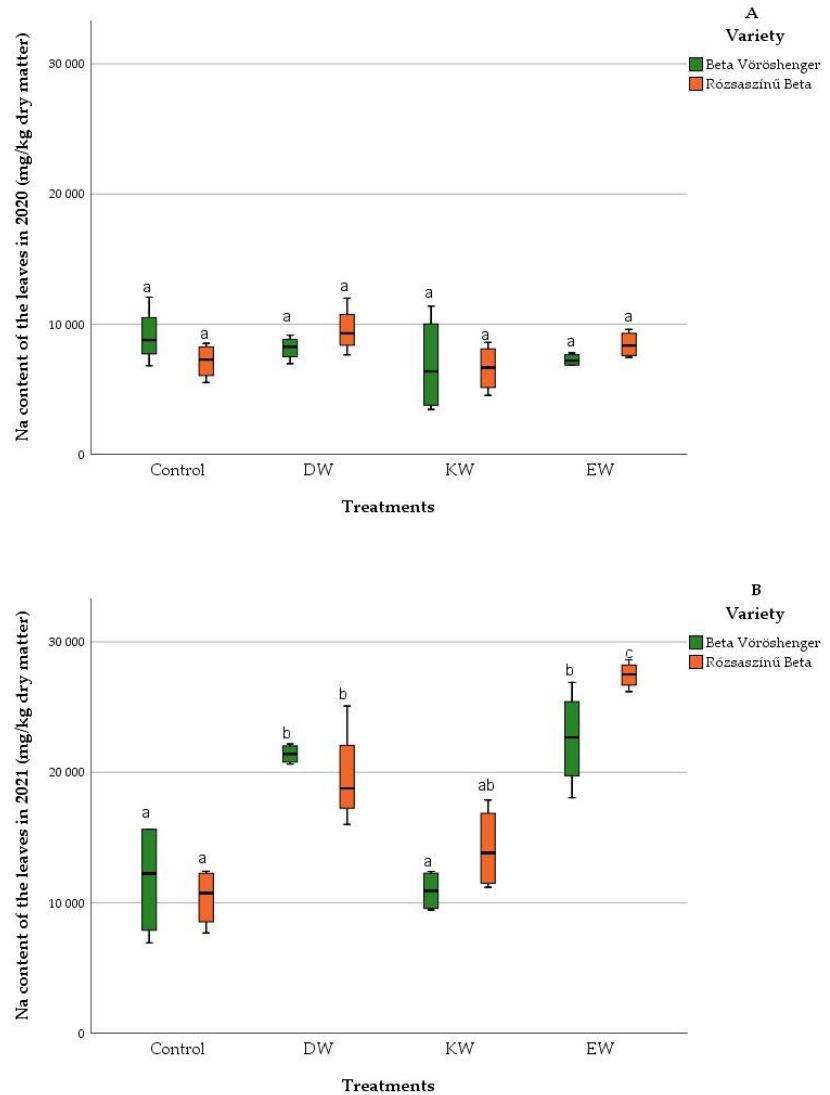
Figure 5. Sodium content of dry leaves of fodder beet cultivars in 2020 ( A ) and 2021 ( B ). The indexes with same letters means no significant differences. N = 32. In 2021, in case of ‘Beta Vöröshenger’, non-parametric Kruskal-Wallis test was used. In all other cases Tukey’s Post Hoc Test, ANOVA, p < 0.05 was used.